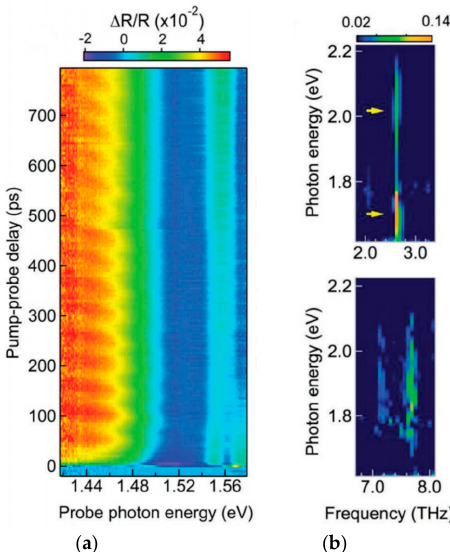
Figure 6. ( a ) Time-domain optical signal measured in Re 6 Se 8 Cl 2 as function of time and probe photon energy. Oscillations in the THz (attributed to COPs) and in the GHz (attributed to propagative coherent acoustic phonons (CAPs)) are respectively observed for energies above and below the optical bandgap at 1.50 eV. ( b ) Intensity of the corresponding spectrum for the (top) 2D in-plane and (bottom) 0D cluster breathing modes showing different resonances related to different opto-acoustic mechanisms. Reprinted with permission from [142], © 2019 WILEY-VCH Verlag GmbH & Co. KGaA.